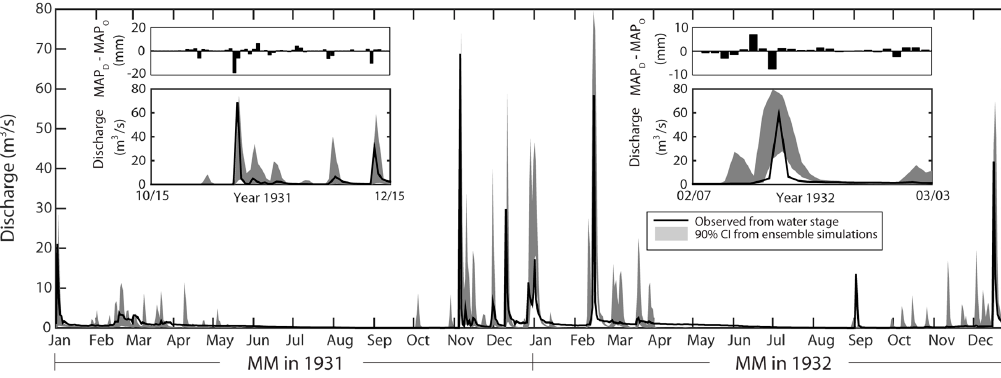
Figure 8. Results for the CATHY model for the 1931–1932 period with a soil crusting hypothesis.